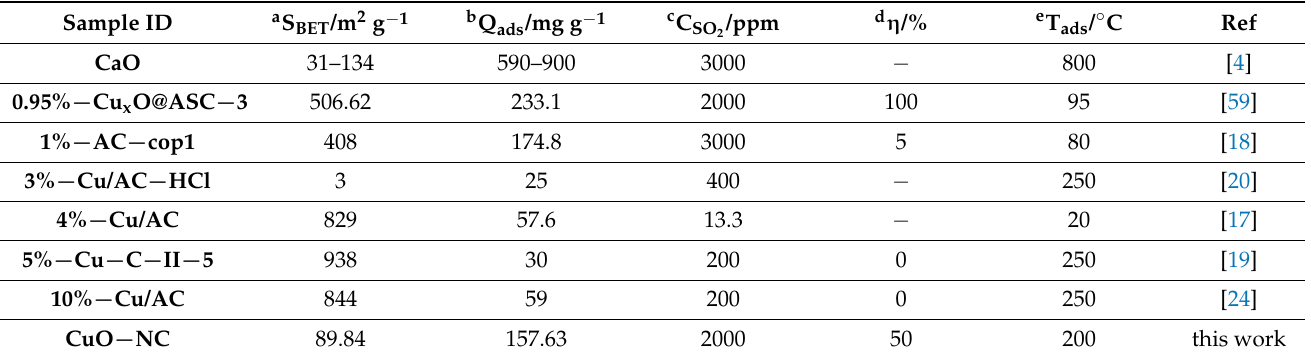
Table 3. Performance comparison between CuO − based composites and earlier reported desulfurizers in the